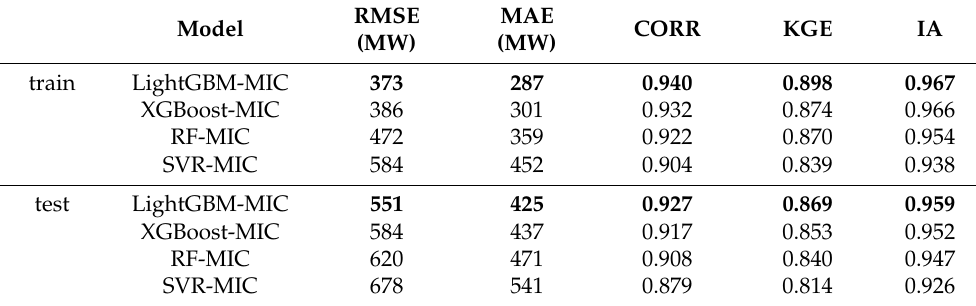
Table 6. Comparison results between LightGBM-MIC and other methods.